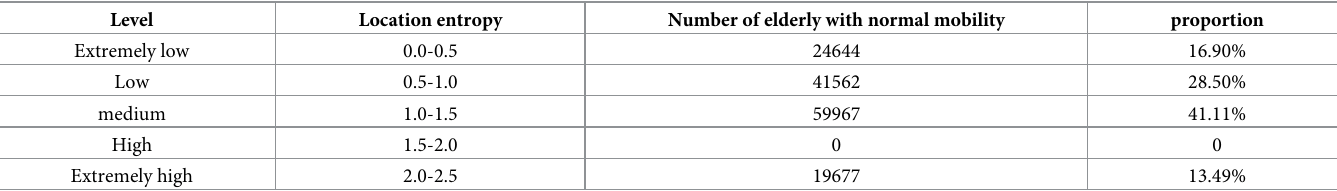
Table 6. Statistics on the number and proportion of the elderly with normal mobility in the entropy sub-grade of the community home care facility area.